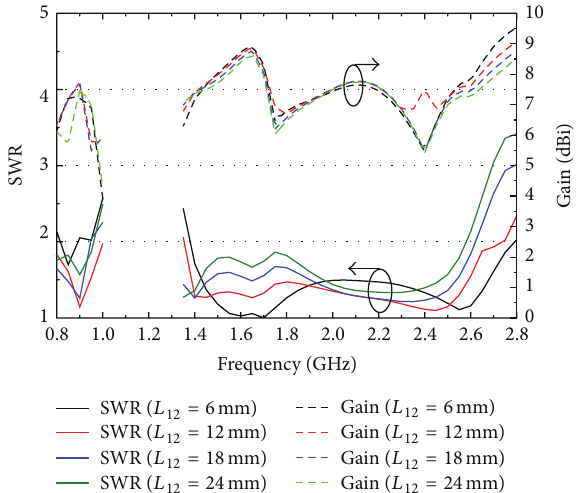
Figure 8: Effects of the 𝐿 12 while keeping 𝐻 8 = 24 mm.